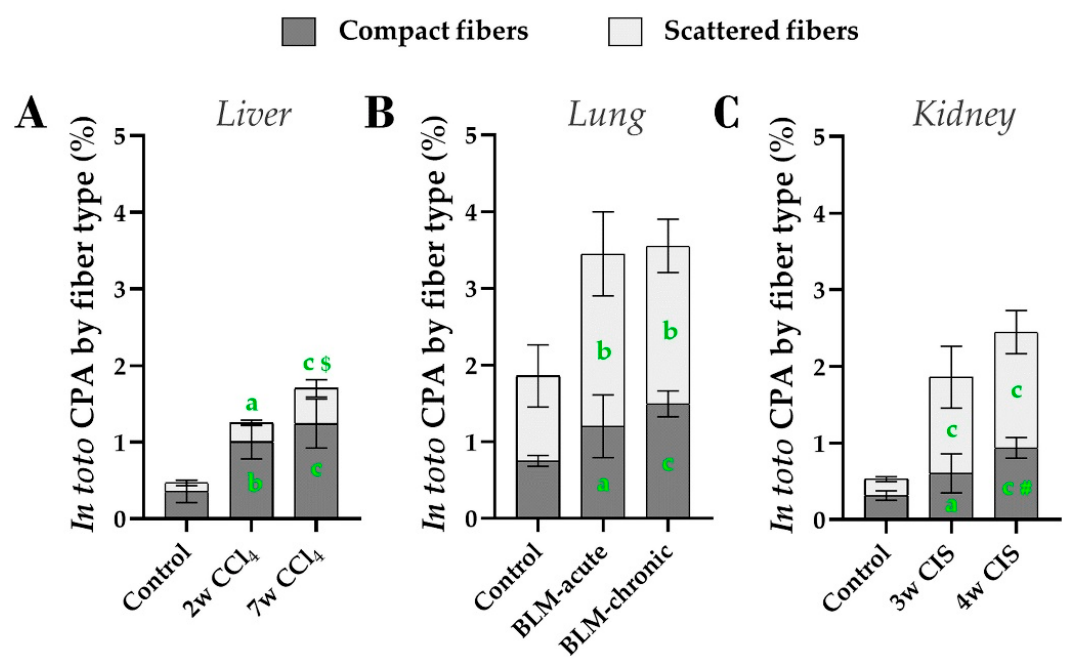
Figure 9. In toto analysis of compact and scattered fibers using PSR MORF detection method, performed in total tissue for ( A ) the livers, ( B ) the lungs and ( C ) the kidneys. Mean ( ± SD) and one-way ANOVA with Fisher’s post-hoc test. a: p < 0.050, b: p < 0.010, c: p < 0.001 vs. controls; # : p < 0.010, $: p < 0.001 last time point vs. intermediate time point.